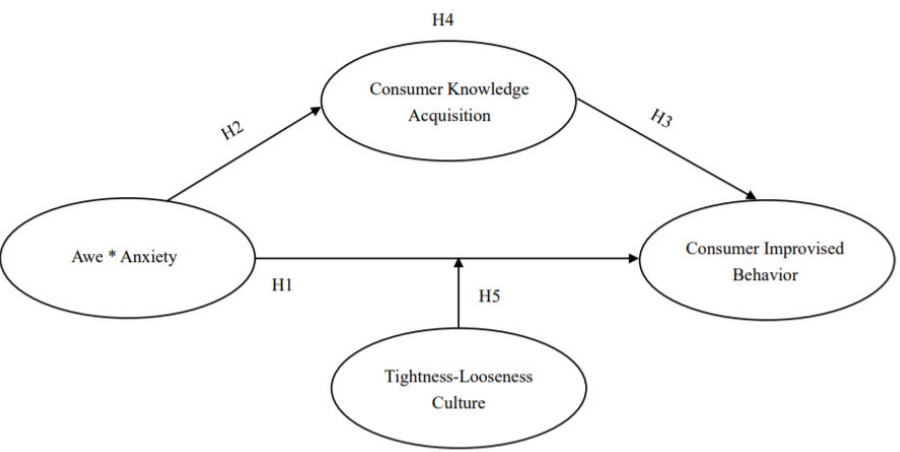
Figure 1. Model Framework Diagram. Note: Awe * Anxiety represents the interaction of the two variables of awe and anxiety.